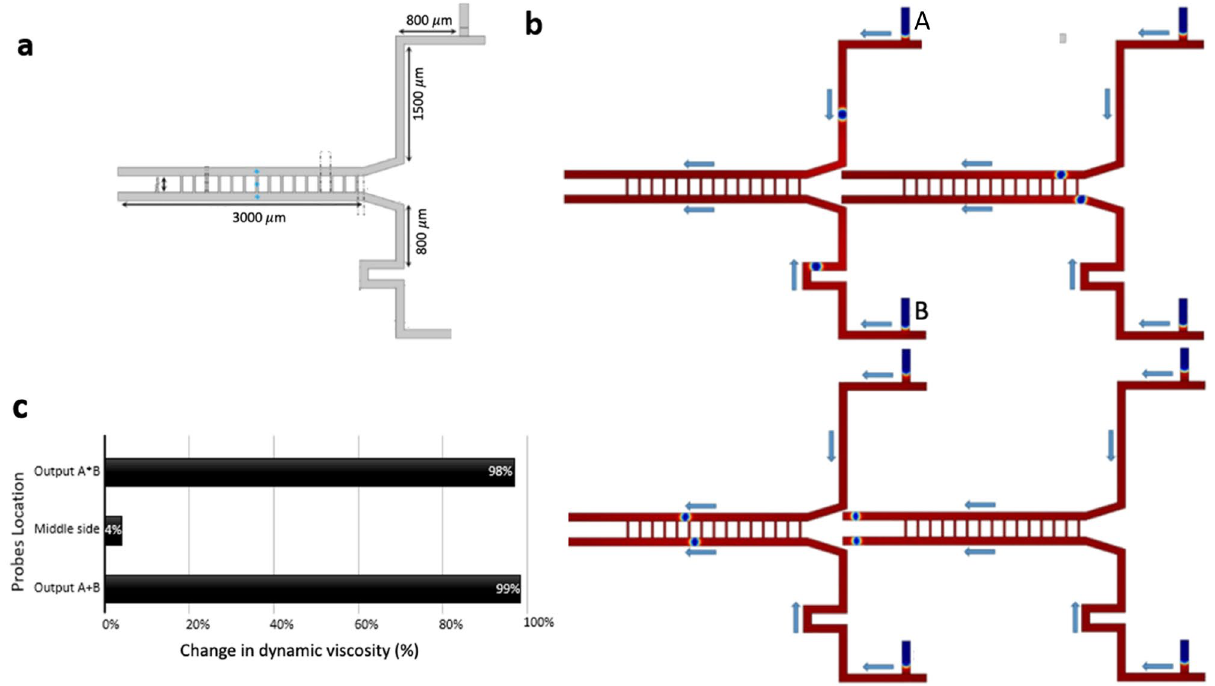
Figure 9. The Synchronizer microfluidic circuit and its verification. ( a ) The design and geometry of the fluidic network and probe points (blue points) of the Synchronizer. ( b ) Series of snapshots for the function of the microfluidic Synchronizer gate during one full cycle while also showing the direction of bubbles flow. ( c ) The percentage change in dynamic viscosity of three points in the upper side, middle side, and lower side. The percentage change of the dynamic viscosity in the medial side of the fluidic network is almost 0, which confirms the proper function of the